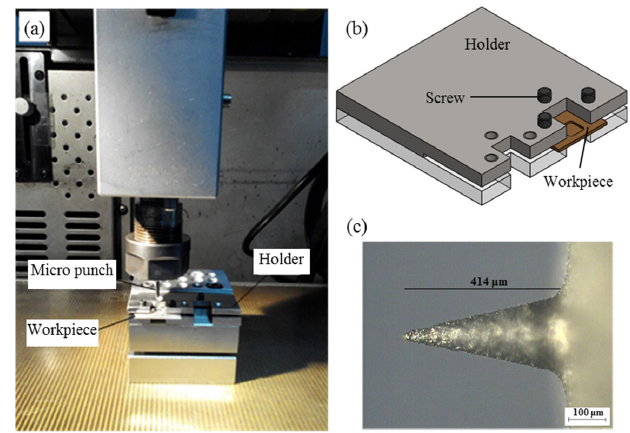
Figure 1. Micro stamping mechanism without a lower die ( a ) experimental setup ( b ) schematic diagram of holder ( c ) micro punch after reverse ‐ EDM (electrical discharge machining). Scale bar = 100 μ m.